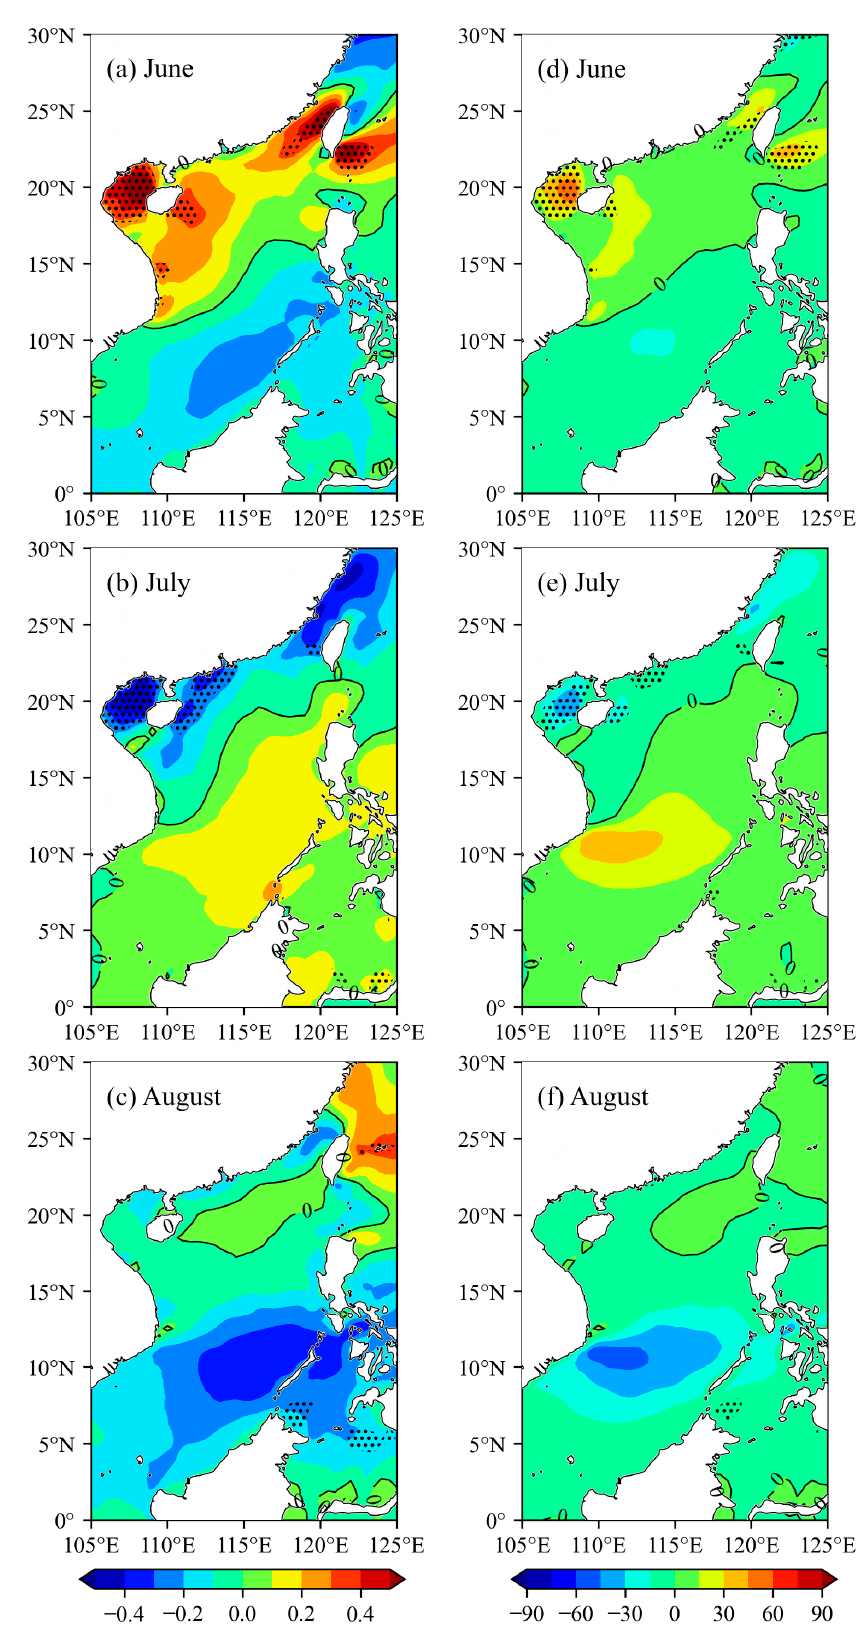
Figure 9. As in Figure 7, but for June ( a , d ), July ( b , e ), and August ( c , f ).